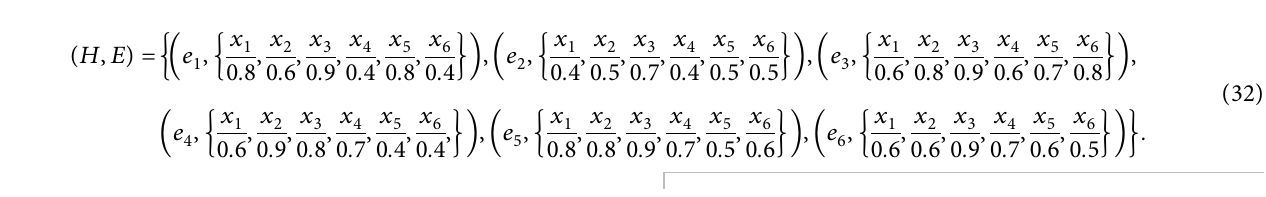
The tabular representation of resultant fuzzy soft set ( H, E ) will be, as in Table 1. The comparison table of the above resultant fuzzy soft set is in Table 2.